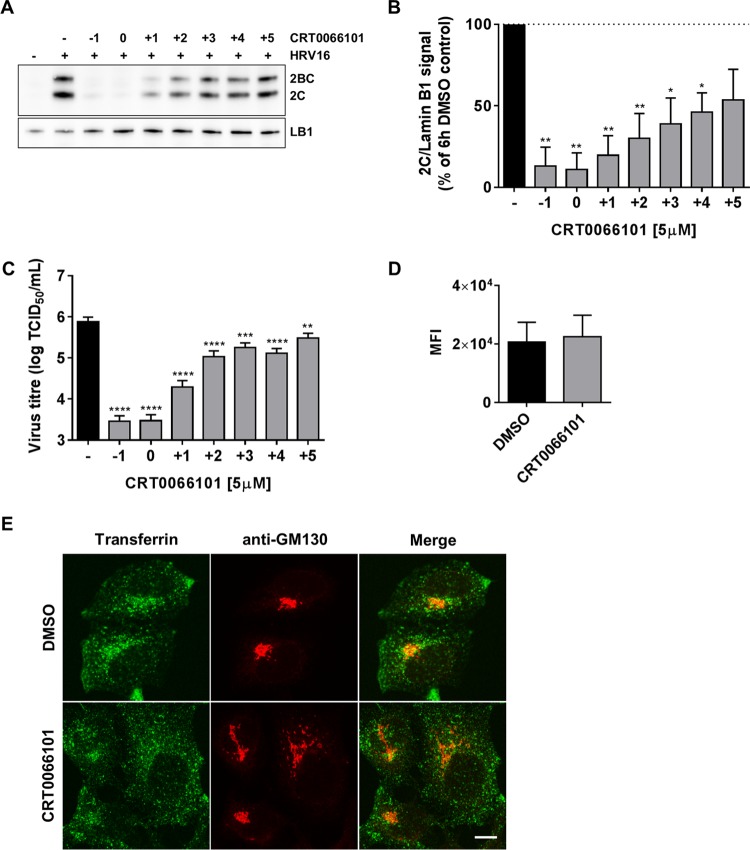
Effect of CRT0066101 on viral entry. (A) HeLa cells were infected with HRV16 (MOI of 20) for 6 h, and CRT0066101 (5 μM) was added at the following different time points: 1 h before infection (−1), during the 1-h virus infection period (0), and every hour after the time of virus adsorption (+1, +2, +3, +4, and +5). Cells extracts were prepared at the end of the 6-h replication period and analyzed by Western blotting with anti-2C and anti-LB1 antibodies. Uninfected cells and DMSO-treated cells infected for 6 h were used as controls. Data from a representative experiment from three independent repeats are shown. (B) 2C Western blots were scanned as described in Materials and Methods and quantified by using ImageJ. The mean 2C/LB1 ratio (±SEM) is shown as a percentage of the value for the DMSO control from three independent experiments. (C) In parallel, virus was extracted from the cell lysates, and viral replication was quantified by endpoint titer determination (TCID50). Results are the means (±SEM) of data from three independent experiments, each done in triplicate. Differences between DMSO-treated cells (−) and the rest of the conditions in both panels B and C were estimated by using one-way ANOVA with Dunnett's post hoc test. *, P < 0.05; **, P < 0.01; ***, P < 0.001; ****, P < 0.0001. (D) HeLa cells were grown on coverslips and pretreated with DMSO or CRT0066101 at 5 μM for 1 h at 37°C. Human transferrin conjugated to Alexa Fluor 488 was added at a 75-μg/ml final concentration, and cells were incubated at 37°C for 1 h in the presence of DMSO or CRT0066101. Cells were stained with an anti-GM130 antibody followed by an anti-mouse antibody coupled to Alexa Fluor 546 and analyzed by confocal microscopy. Transferrin quantification is shown as the mean fluorescence intensity (MFI) from multiple low-power images. For each experiment, images from five different low-power fields with approximately 250 cells per field were quantified by using ImageJ. Data shown are the means (±SEM) from three independent experiments. No statistically significant difference between DMSO- and CRT0066101-treated cells was found by performing a two-tailed t test. (E) High-power images of HeLa cells showing internalized transferrin (green) and Golgi membrane (GM130) (red) staining from a representative experiment (bar = 10 μm).